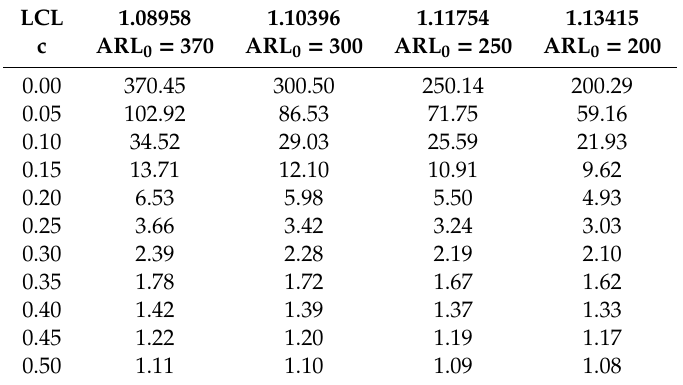
Table 17. The ARLs for the proposed chart when n = 25, LND (0.95,0.40), USL = 7.2452, and LSL = 0.9228.